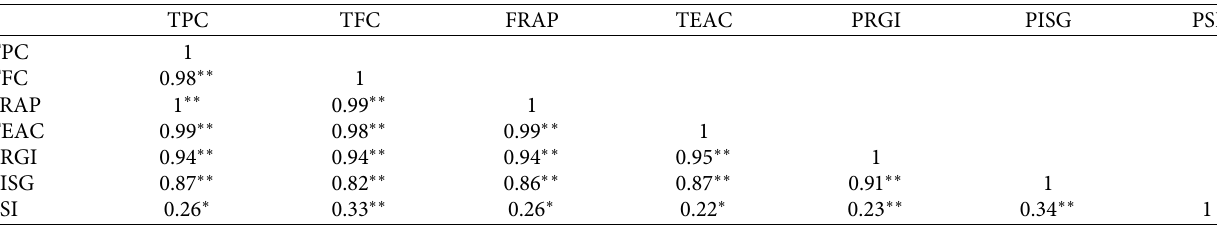
Table 2: Correlation between phenolic compounds, antioxidant, and antifungal activities